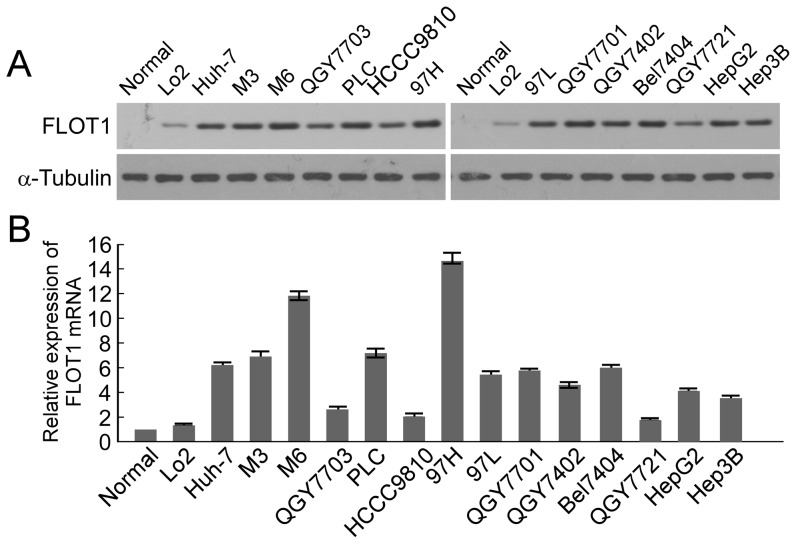
Expression analysis of FLOT1 in HCC cell lines and normal hepatic cell line.(A) Expression of FLOT1 protein in Lo2, cultured HCC cell lines (Huh7, M3, M6, QGY7703, PLC, HCCC9810, 97L,97H, QGY7701, QGY7402, Bel7404, QGY7721,HepG2, and Hep3B), and one case of normal liver tissue by Western blotting. (B) Expression of FLOT1 mRNA in the Lo2, normal liver tissue, and cultured HCC cell lines real-time reverse transcription-PCR. Expression levels were normalized for GAPDH. Columns, mean from three parallel experiments; bars, SD.